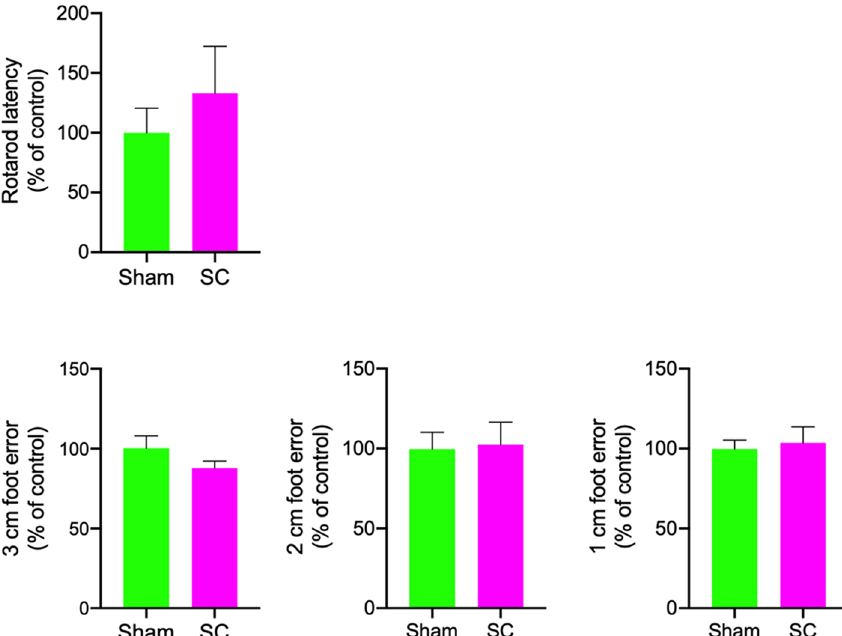
Figure 1. Neuromotor performance. Neuromotor performance in rats receiving repeated sub-concussion (SC) or sham procedure for 2 weeks were assessed with rotarod and beamwalk tests using 3, 2, and 1 cm. The latency of rats stayed on the rotating rod of rotarod test is presented as percent of the mean of Sham control group (mean ± SEM). The number of foot errors on 3, 2, and 1 cm beamwalk are also shown as percent of the Sham control group. Statistical significance was assessed with 2 tailed t-test ( p < 0.05, n = 8). (adapted from Lavender et al. 18